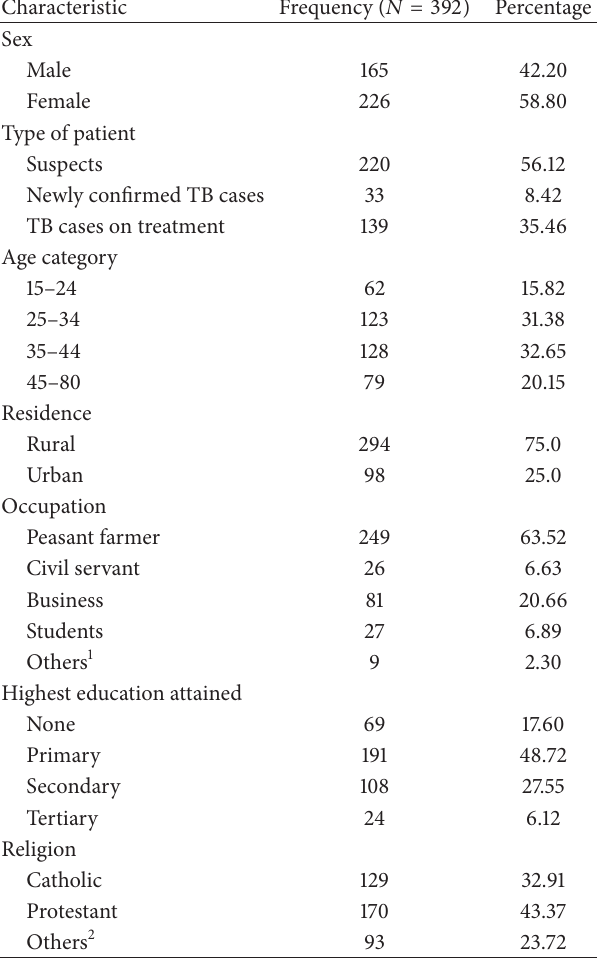
Table 2: Baseline characteristics of the patients attending health facilities in Kamuli district, March–May 2012.